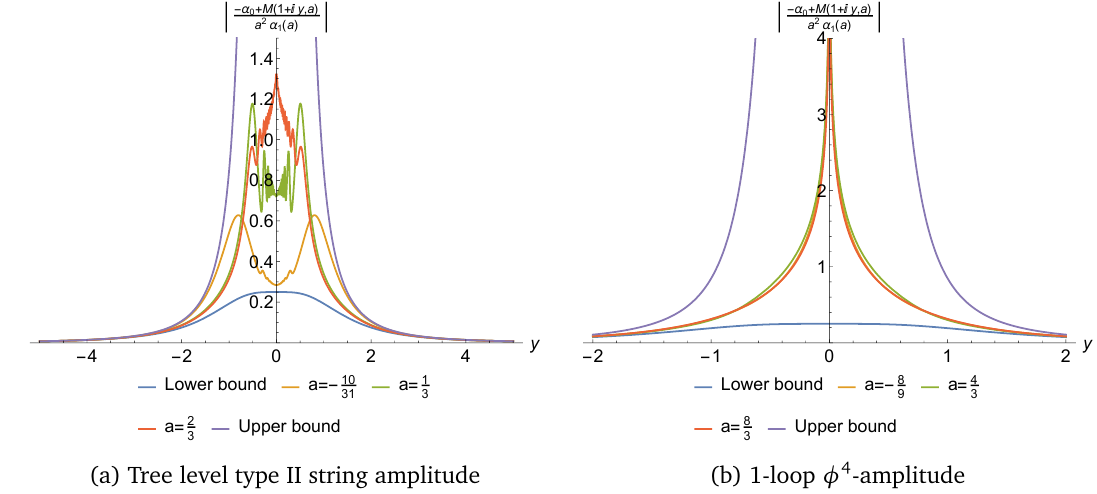
Figure 6: Bounds on amplitude, as in theorem (6.1), are satisfied by Tree level type II string amplitude and 1-loop φ 4 -amplitude. These bounds on amplitude valid for complex ˜ z